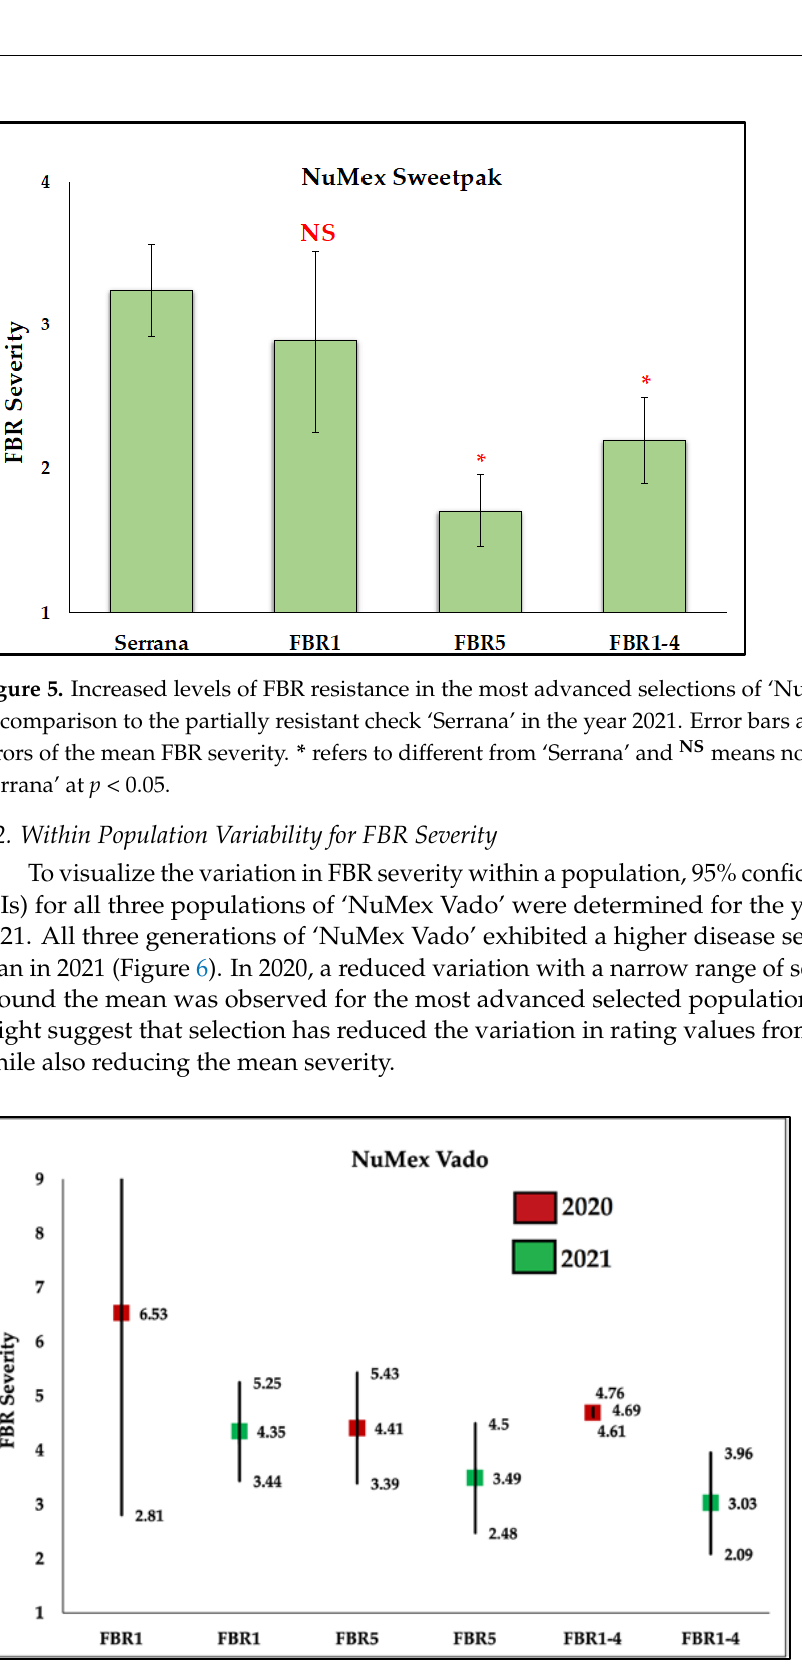
Figure 6. 95% confidence intervals (CIs) providing the range of possible values around point esti- mates for FBR severity of three selected populations (FBR1, FBR5, and FBR1-4) of ‘NuMex Vado’ in 2020 and 2021.